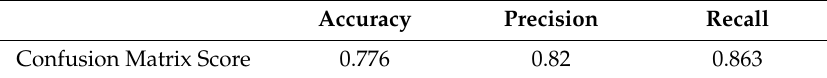
Table 2. Answer retrieval performance